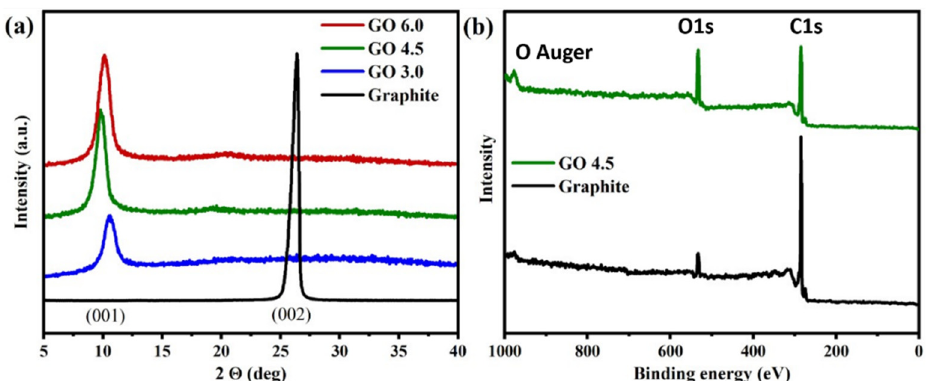
Figure 2. ( a ) XRD profile for GO 3.0 g, GO 4.5 g and GO 6.0 g samples. ( b ) XPS survey spectra of graphite and GO 4.5 sample. Table 1. 2 θ values of graphite and GO produced, and its interplanar distances.